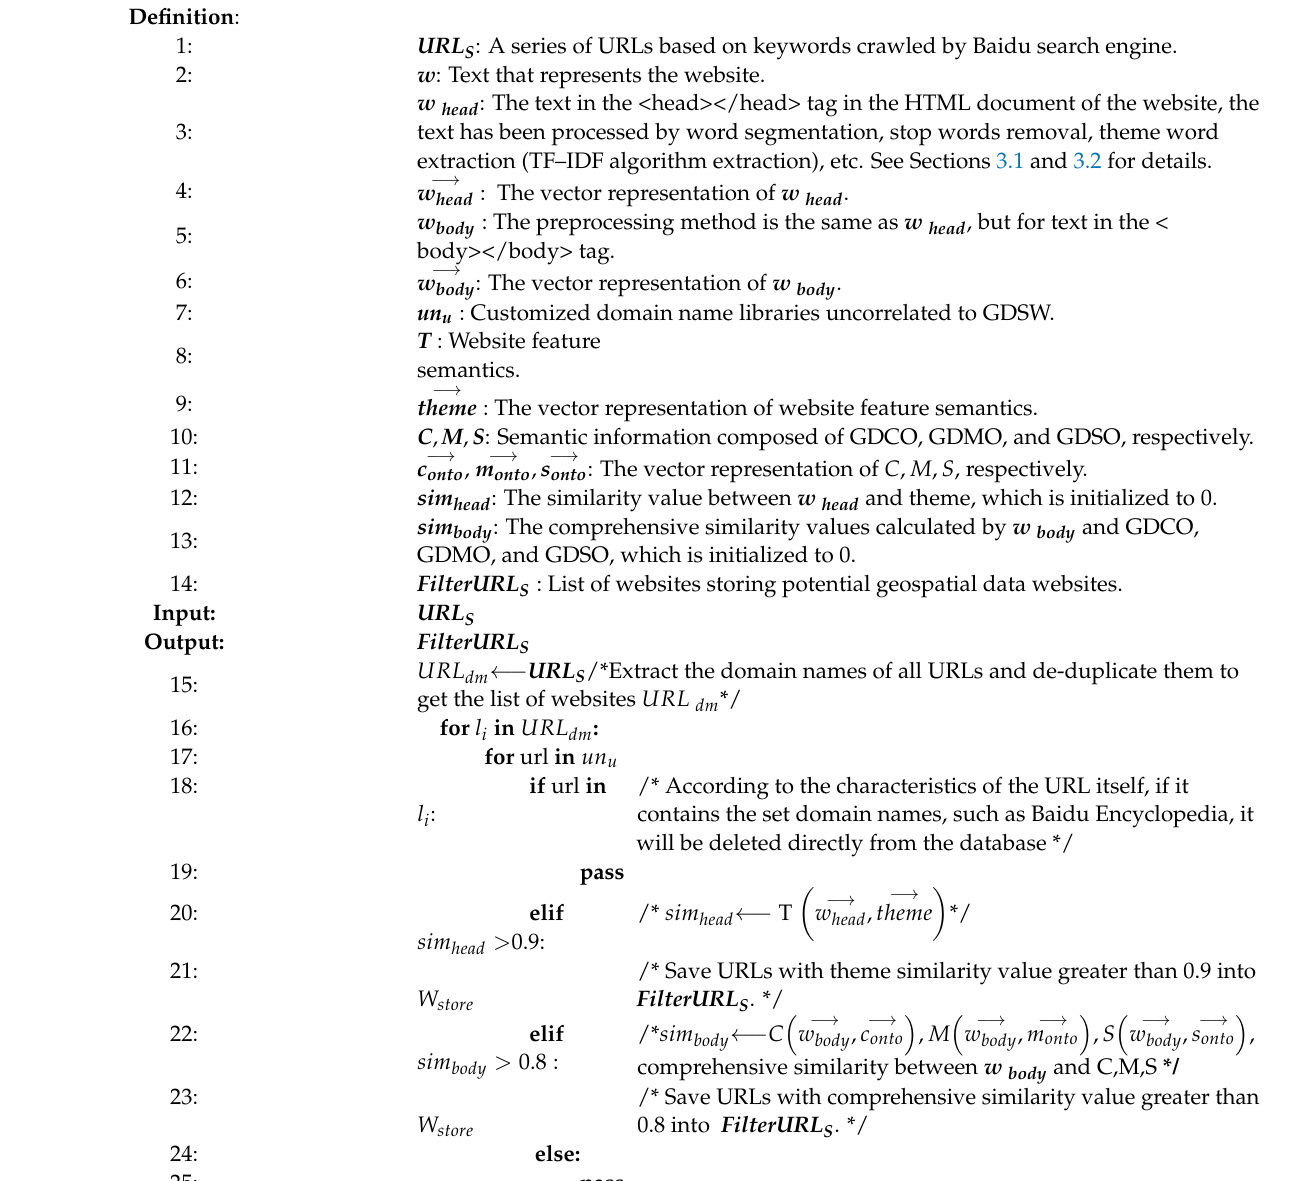
Algorithm 1 Filtering